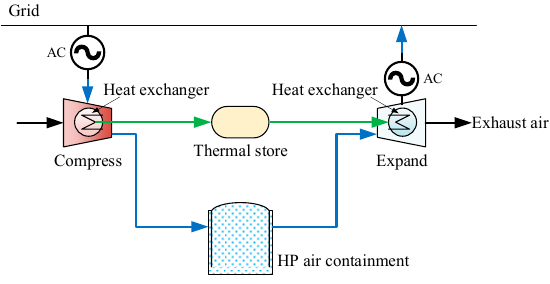
Figure 3. Schematics of the isothermal CAES system.